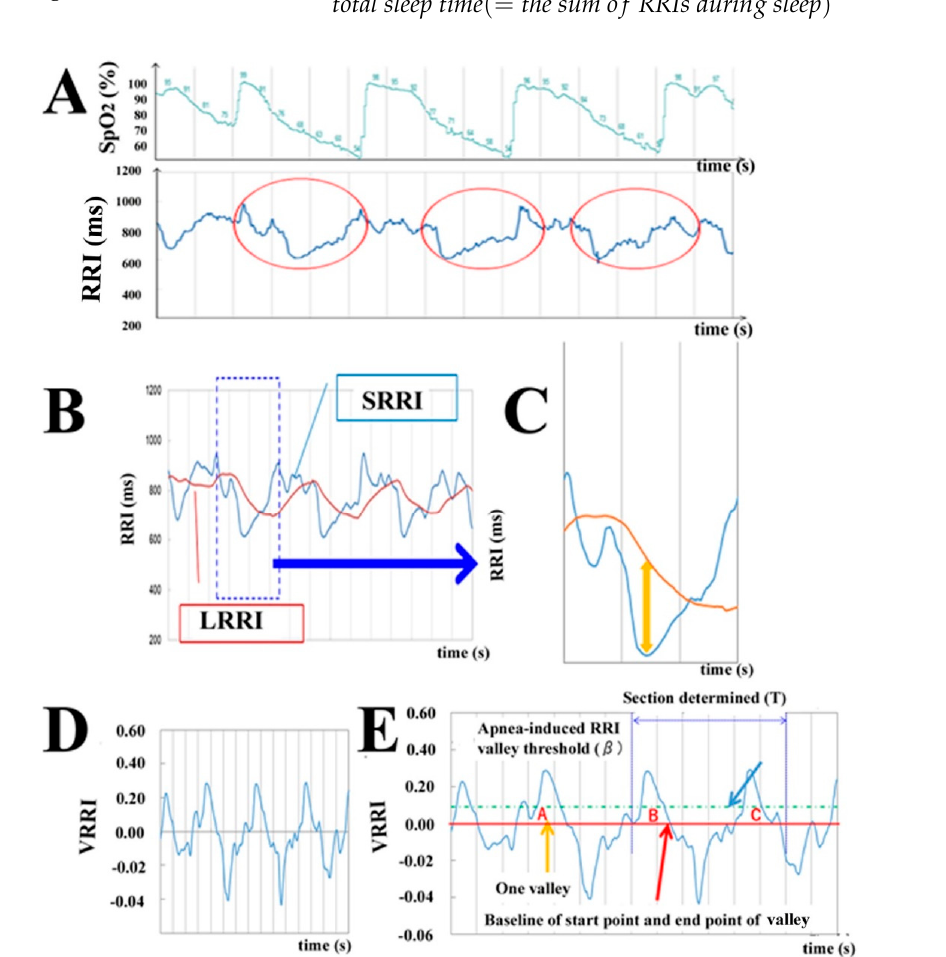
Figure 3. Analysis of the R-R interval (RRI). ( A ) The graphs of SpO 2 and RRI when apnea and CVHR occur. The horizontal axis indicates time, and the vertical axis shows SpO 2 (%, upper trace) and RRI (ms, lower trace). Note that the occurrence of apnea and CVHR (shown by red circles) is repeatedly observed. ( B ) The method of measuring the depth of the RRI valley to detect the deep valley of the RRI in CVHR. The long average of RRI (LRRI) and short average of RRI (SRRI) were calculated from the RRI of 60 s and 5 s, respectively (details in Methods). ( C ) The large-scale graph of SRRI and LRRI at the location where CVHR occurs. The horizontal axis indicates time (s), and the vertical axis indicates RRI (ms). It can be seen that, considering LRRI minus SRRI as the depth of the valley, the deep valley of RRI caused by CVHR indicated by the orange arrow can be identified. ( D ) Depth of the valley of the RRI fluctuation (VRRI) at a certain time (t) corrected by LRRI 2 (details in Methods). ( E ) VRRI during apnea. The depth VRRI exceeds the threshold ( ≥ 0.090) at three points: ( A – C ), in this case.